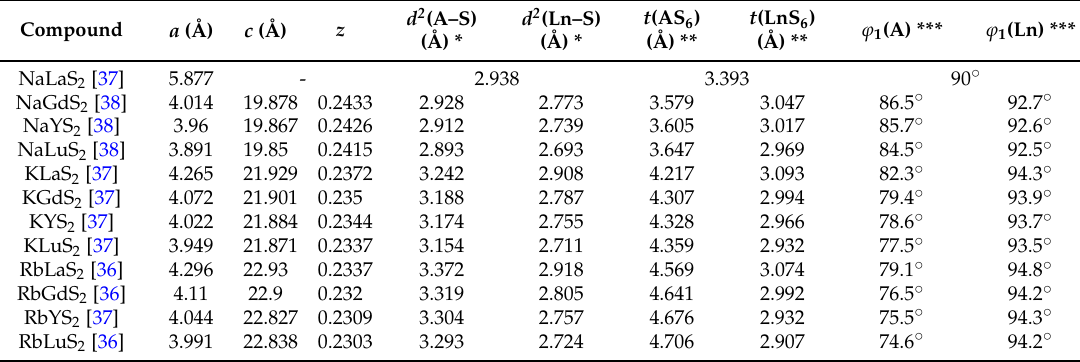
Table 2. Structural parameters of all discussed ALnS 2